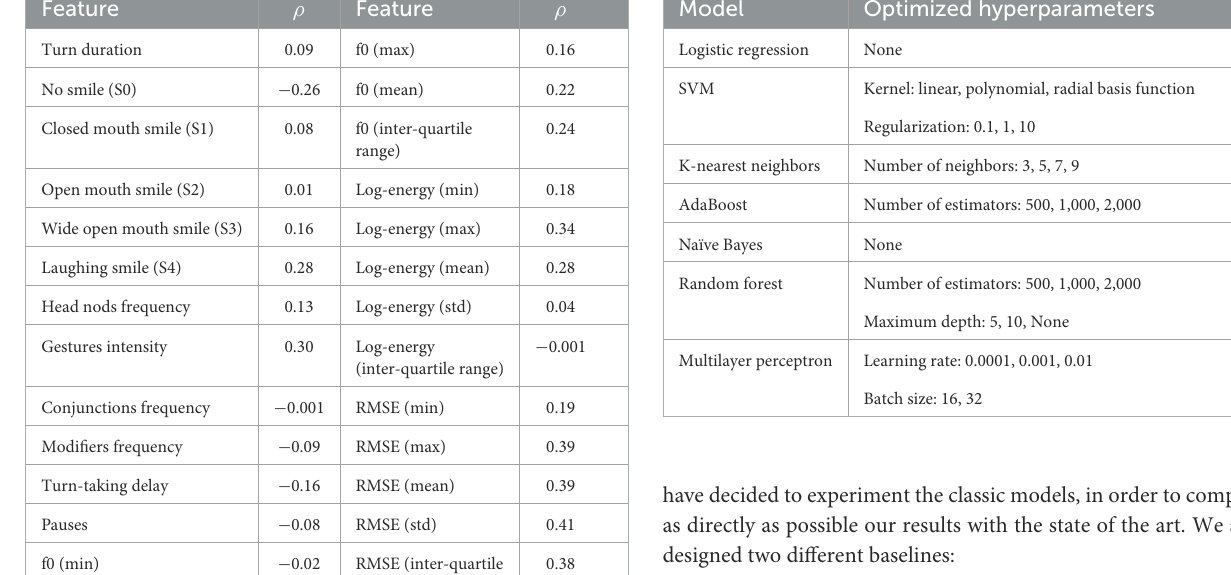
TABLE 2 Hyperparameters that were optimized using the nested cross-validation procedure for each classifier. Model Optimized hyperparameters Logistic